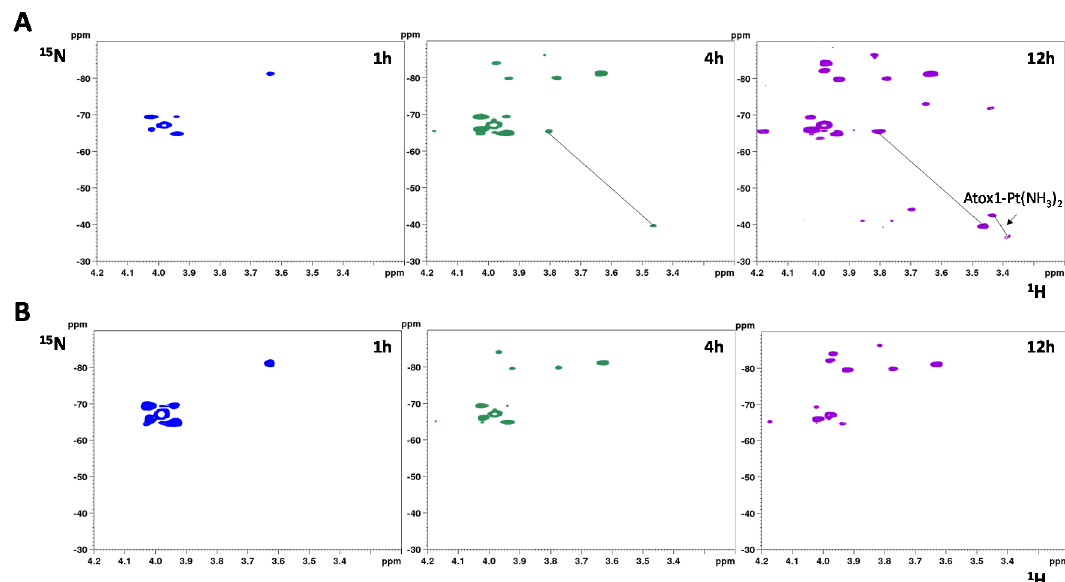
Figure 6. ( A ) Two-dimensional 1 H, 15 N-HSQC spectra of 15 N-labeled cisplatin recorded at different time intervals after mixing with one equivalent of oxidized Atox1 (70 µM) in 25 mM phosphate buffer (pH 7.0), in the presence of GSH/GSSG (140 µM/140 µM) and EDTA (210 µM). ( B ) Two-dimensional 1 H, 15 N-HSQC spectra of 15 N-labeled cisplatin recorded at different time intervals after mixing with one equivalent of oxidized Atox1 (70 µM) in 25 mM phosphate buffer (pH 7.0), in the presence of EDTA (210 µM) and in the absence of GSH/GSSG.